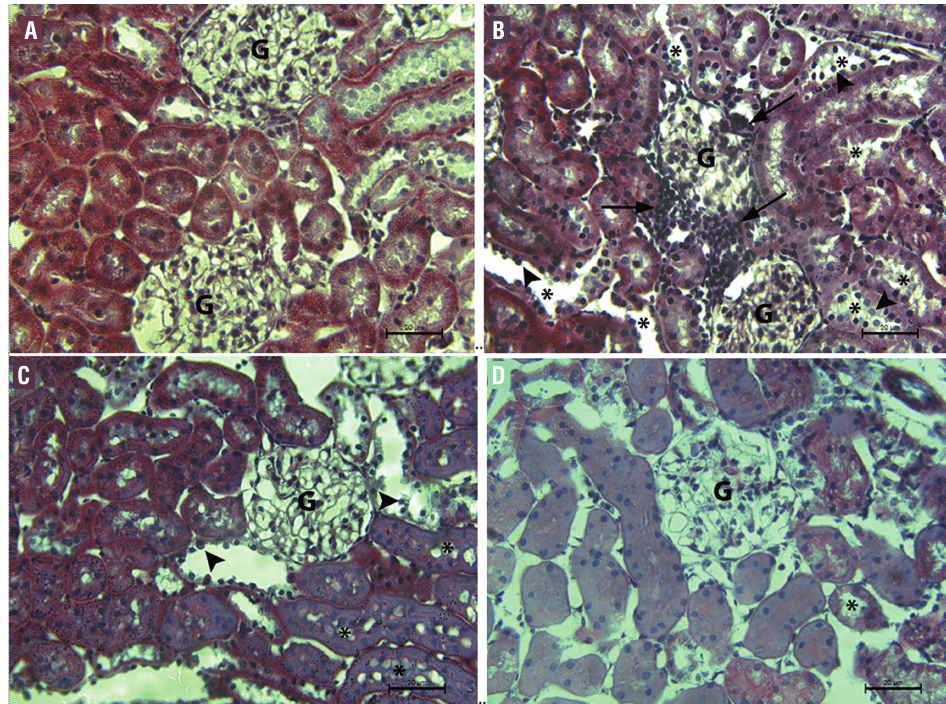
Figure 1 (A-D) - Representative photomicrographs of Masson’s trichrome staining of the renal cortex in the sham group (a) and sepsis group (b) 5mg/kg (c) and 10mg/kg tadalafil+sepsis groups (d). Arrows indicate areas of inflammatory cell